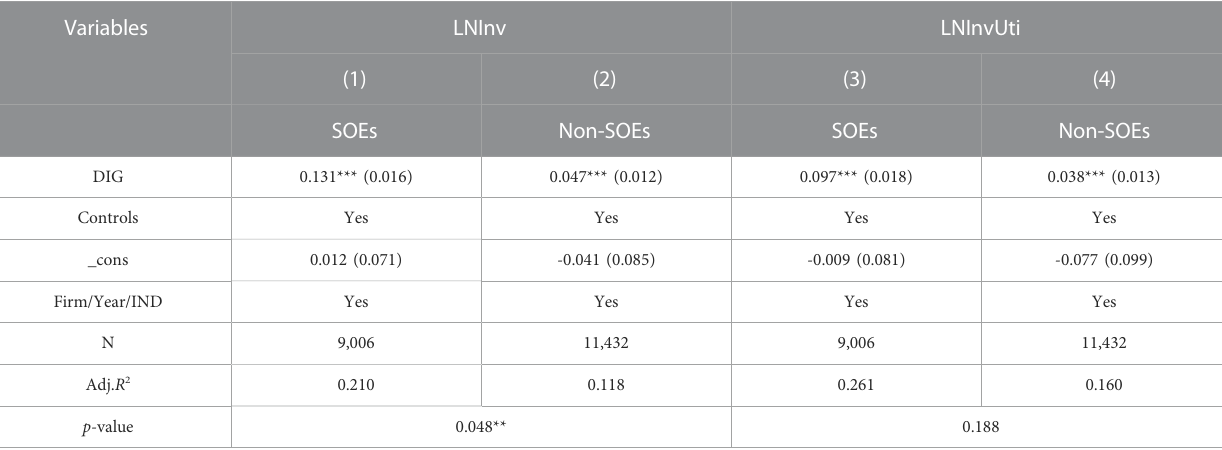
TABLE 11 Heterogeneity test based on property rights.